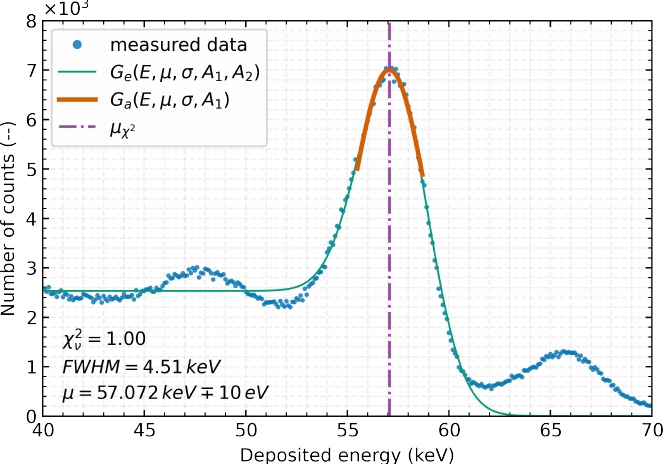
Figure 3. Part of the measured energy spectrum of the radiation produced by the X-ray fluorescence of a Tantalum target with a 500µm Si Timepix3 detector without temperature stabilisation. Measured data (blue markers) together with the G e ( E , A 1 , A 2 , µ , σ ) function (combination of Gaussian and complementary error function—green line) and with the result of the final fit of the G a ( E , A 1 , µ , σ ) function (orange line) to the Ta- K α 1 line. The resulting position of the µ χ 2 of the evaluated peaks determined by χ 2 minimisation is 57.072keV (purple dashed dotted line). Considering the statistically significant number of observed events, the maximum size of statistical uncertainties was determined to be <80 counts in the range shown, the individual error bars are not plotted to the measured points for